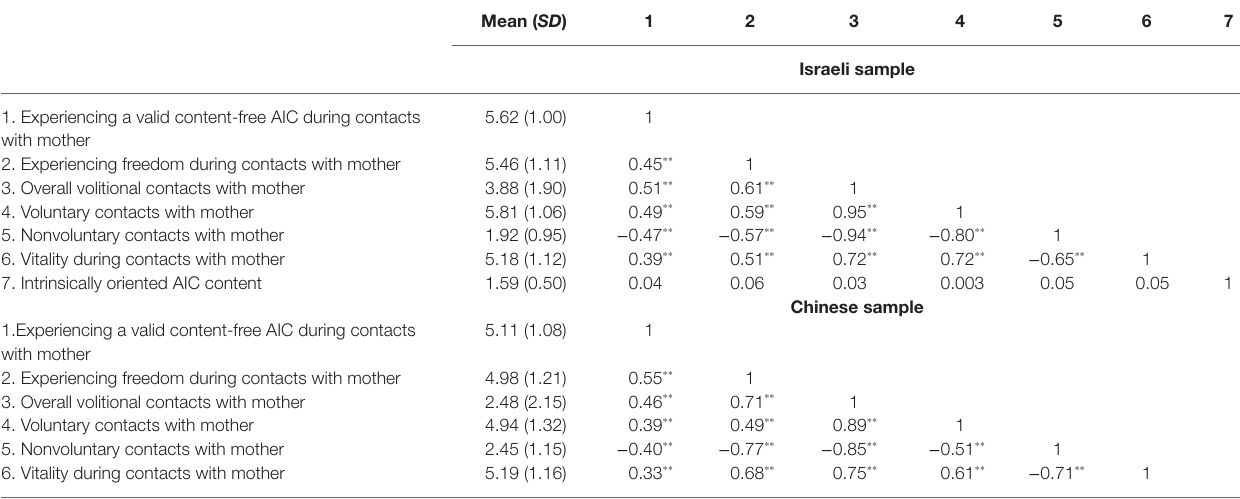
TABLE 2 | Descriptive statistics and correlation among research